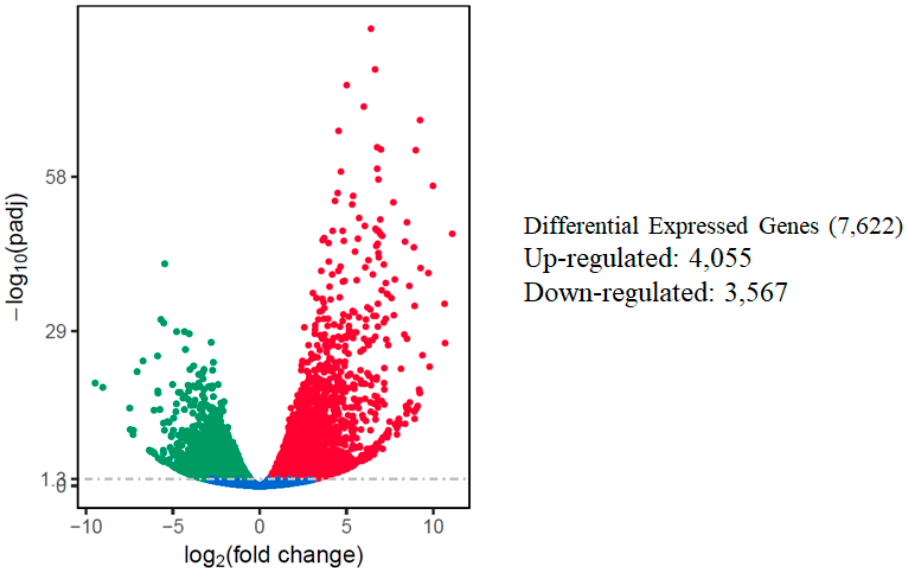
Figure 3. Summary of di ff erentially expressed genes (DEGs) in the watermelon leaves during salt stress. Each point represents a gene; blue dots indicate no significant di ff erence; red dots indicate up-regulated DEGs; green dots indicate down-regulated DEGs. The horizontal axis shows the fold change of genes between di ff erent samples (padj < 0.05), and the vertical coordinate indicates the statistically significant degree of changes in gene expression levels at − log10 (padj p -value).